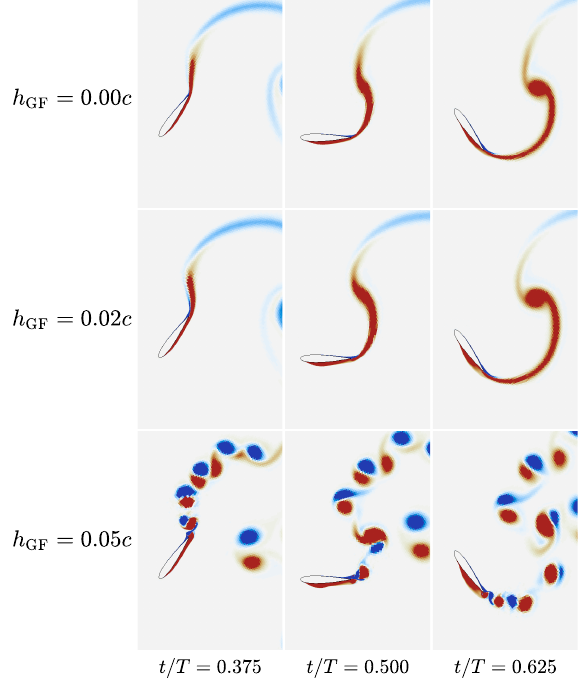
Figure 7. Normalized z-vorticity field during reversal for three double GF heights at f ∗ = 0.18. Positive vorticity in red, negative vorticity in blue.